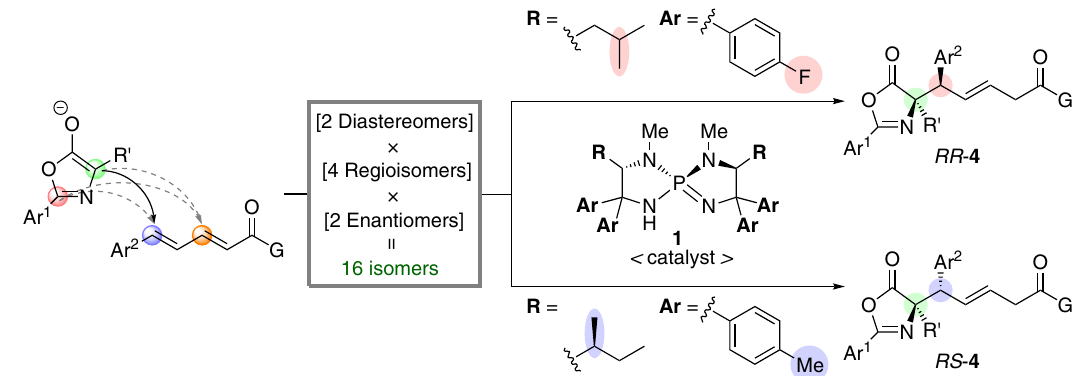
Figure 1 | Research overview. Small change in the catalyst structure enables diastereodivergent 1,6-addition of azlactones to d -aryl dienyl carbonyl compounds. NATURE COMMUNICATIONS|8:14793|DOI: